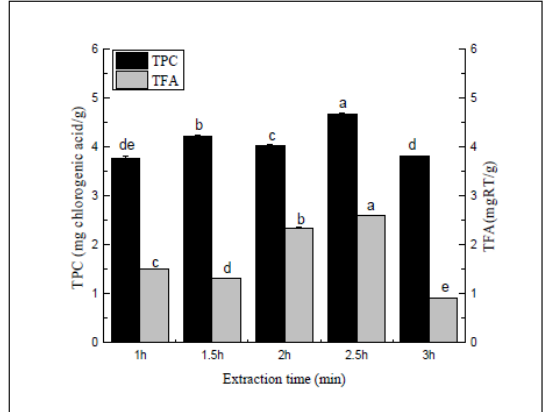
Figure 4. Extraction time (min). Three independent experiments were carried out for each analysis. Result is expressed as a mean ± SD ( n = 3). Values with the different letters in the column are significantly different by Duncan’s multiple range test ( p < 0.05).